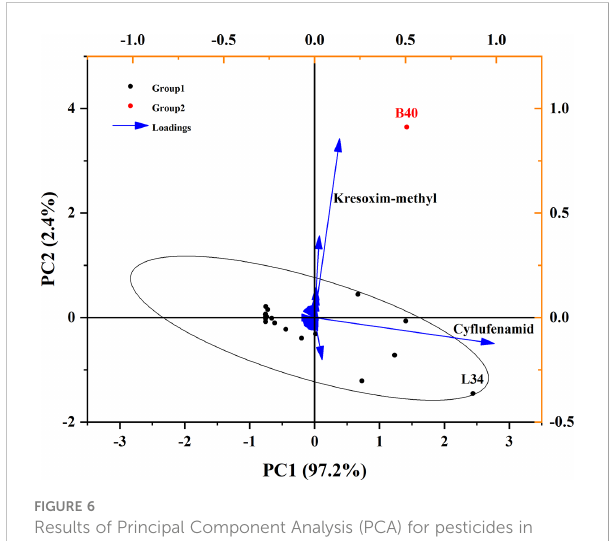
FIGURE 6 Results of Principal Component Analysis (PCA) for pesticides in seawater.